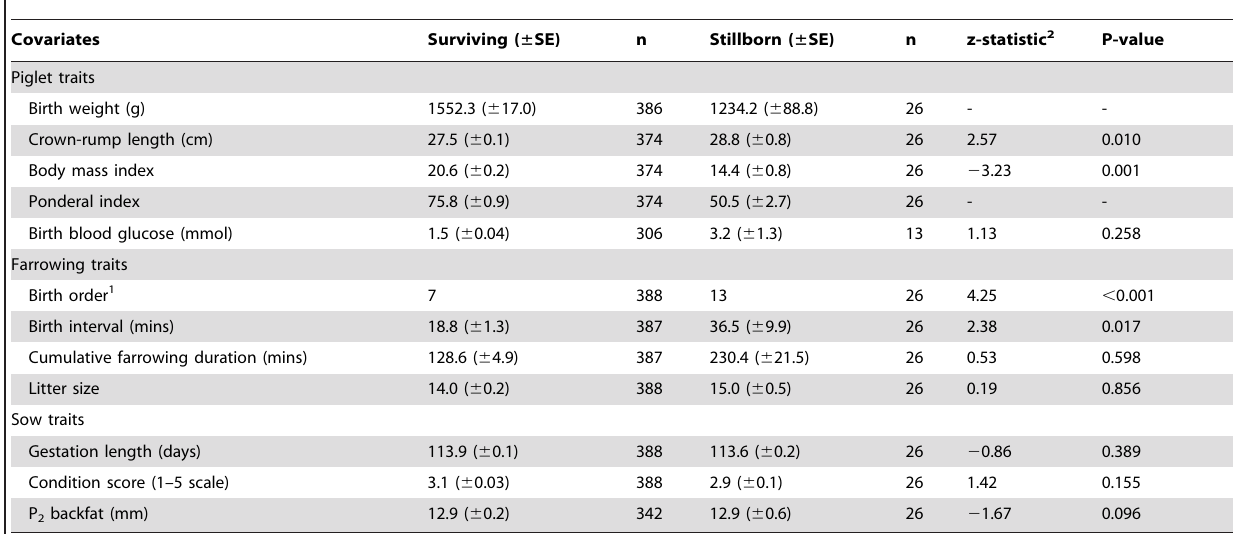
Table 2. Prenatal survival indicators (means and standard errors (SE)) comparing surviving piglets with stillborn piglets.